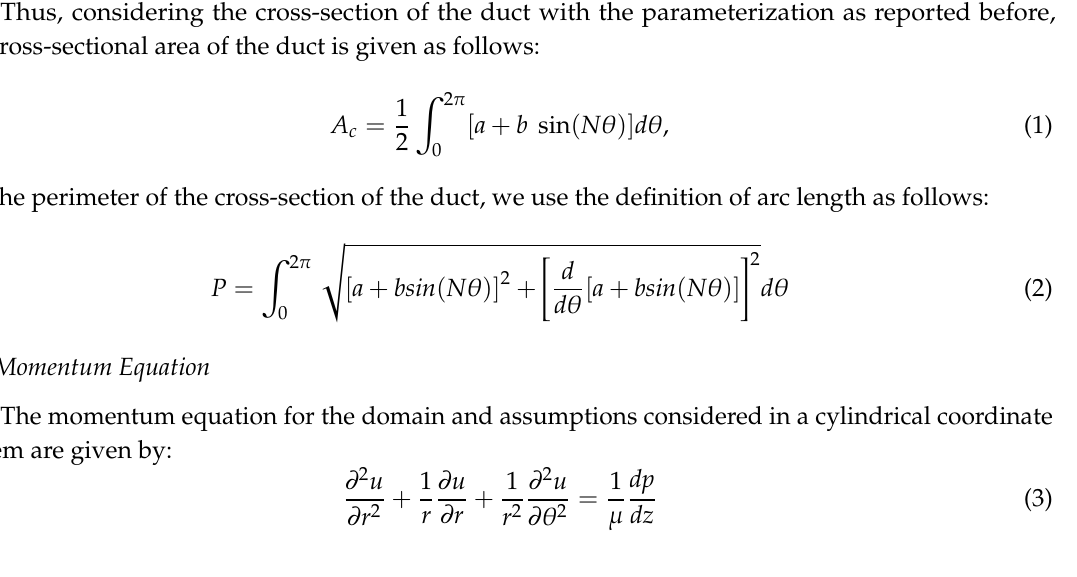
Figure 1. ( a ) Aspect ratio in a corrugated duct; ( b ) sine-type corrugated Figure 1. (a) Aspect ratio in a corrugated duct; (b) sine-type corrugated duct.